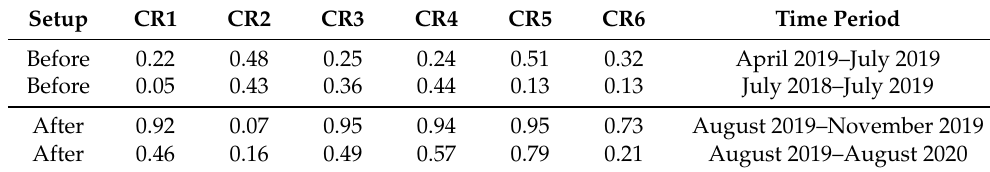
Table 2. Coherence values corresponding to each pixel containing a corner reflector. We show coherence results over a four-month period (top rows) and over a year (bottom rows) before and after the installation of the corner reflectors.